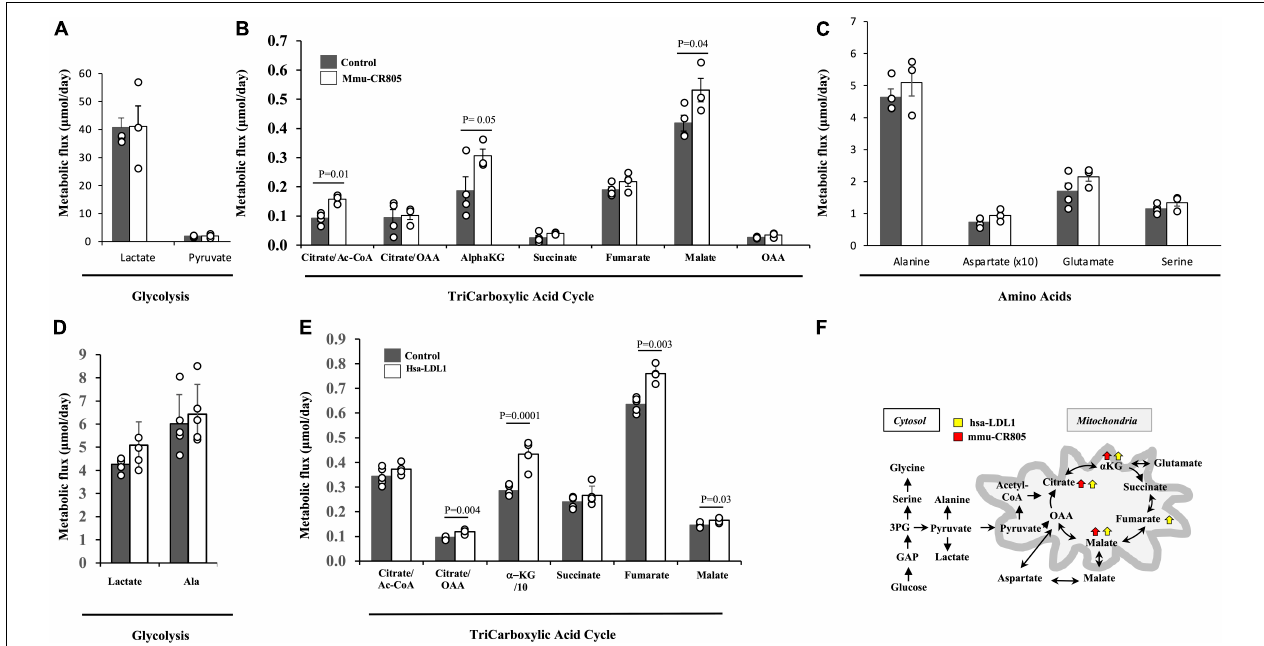
FIGURE 3 | mmu-CR805 and hsa-LDL1 increase the TCA cycle activity. (A–C) The MLE12 cells were transfected with either 12 nM mmu-CR805 or a non-targeting sequence. (D,E) The BEAS-2B cells were transfected with either hsa-LDL1 or a non-targeting sequence. At 30 h post-transfection, the cells were exposed to 20 mM of [U- 13 C]glucose for 12 h and harvested, and the metabolic flux was determined according to 13 C label incorporation into various metabolites. Metabolic flux of glycolysis (A,D) , TCA cycle activity (B,E) , and amino acid turnover (C) . Metabolic flux was determined as a product of fractional flux multiplied by the concentration (pool size) of a metabolite. Fractional flux was calculated as 13 C enrichment of a product metabolite over the [ 13 C] enrichment of the precursor, i.e., [U- 13 C]glucose. All quantifications are presented as means from at least four independent experiments ± S.E.M ( Supplementary Table 2 ). Graphs are representative of at least two independent biological experiments of four replicates. (F) Schematic representation of the major findings on the glucose metabolic flux regulated by the forced overexpression of mmu-CR805 and